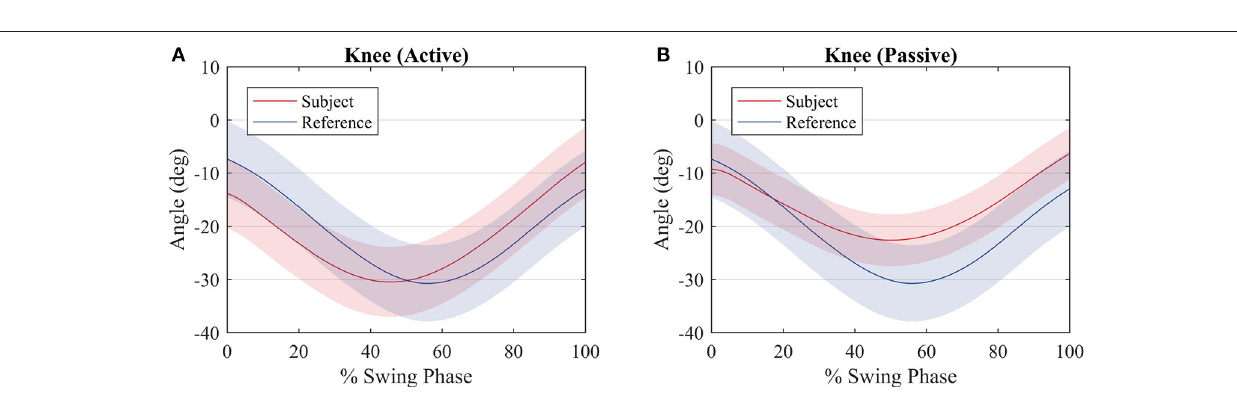
FIGURE 9 | Average knee joint displacement of the subjects (red) and average hip joint displacement during the procedure to compute the reference values (blue) for an (A) active walk and a (B) passive walk. Shaded regions denote the standard deviation of the